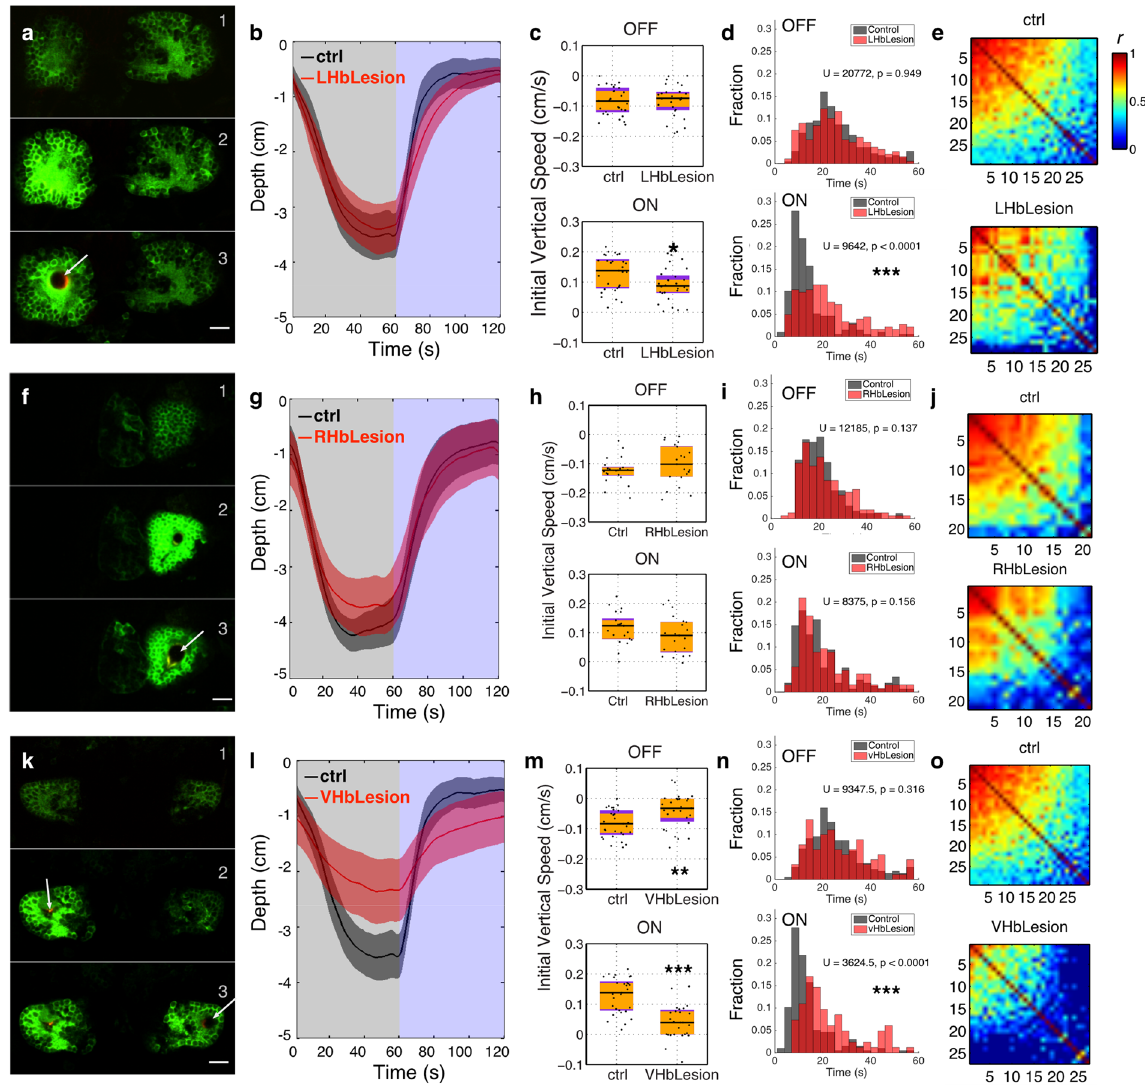
Figure 7. Lesion of the habenula inhibits masking of vertical migration. Effects of lesioning the left dorsal (a–e ). N = 29 for control group, 28 for lesion group ) , right dorsal ( f , j ). N = 21 for each group ) and ventral ( k – o ). N = 29 for control group, 27 for lesion group ) habenula. ( a , f , k ) Stills from a time-lapse recording taken during the lesioning process, showing the habenula before (top), during (middle) and immediately after (bottom) lesioning. Lesioning leads to the formation of a bubble (arrow) and an extended rise in GCaMP3 fluorescence in surrounding cells. ( b , g , l ) Average position of fish during light ON and OFF. Shadows represent 95% CIs. ( c , h , m ) Initial vertical speed during light ON and OFF. Horizontal black lines indicate median values, black dots show individual fish, purple blocks show the 25th and 75th percentiles and orange blocks show 95% CIs. ( d , i , n ) Time taken to migrate half-way up or down the water column. The bars show the percentage of fish that reach this mark within the indicated time. ( e , j , o ) Correlation between the movement of individual